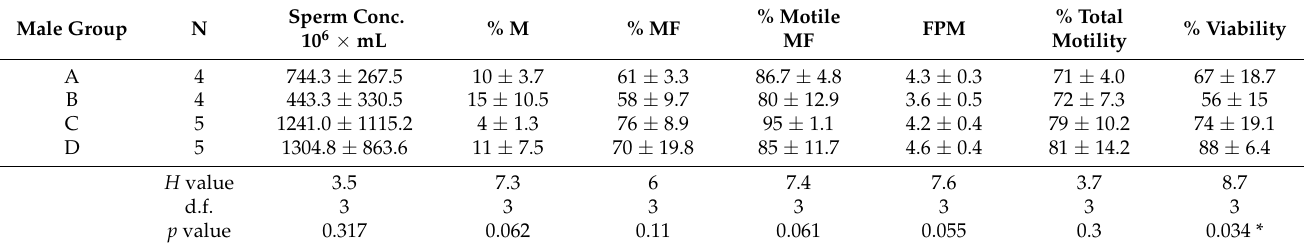
Table 2. Summary table of mean values ( ± s.d.) of fresh sperm concentration, motility, and viability measures of fresh semen samples placed in each of the four experimental CPA groups (A, B, C, D). Below mean values are the results of Kruskal–Wallis test of differences for each semen metric included in the table. M = % motile sperm; MF = % forward-moving sperm; % motile MF = proportion of motile forward-moving sperm; FPM = forward progressive motility.